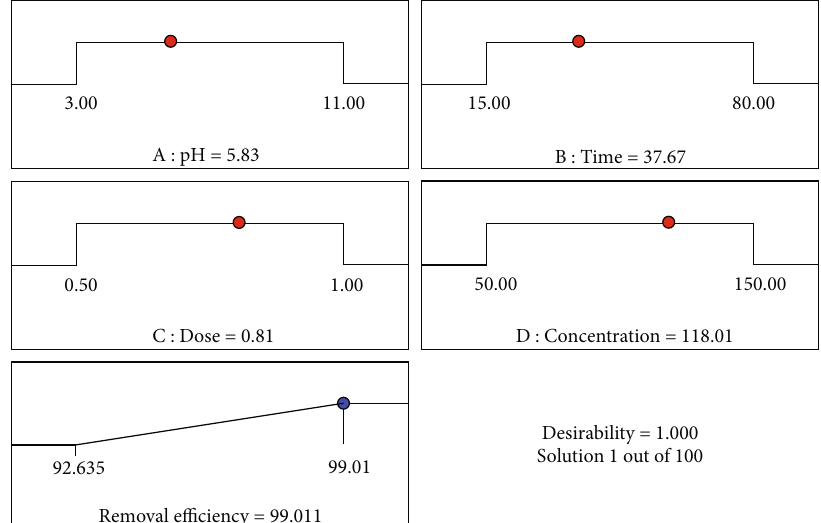
Figure 8: Desirability e ff ect for the CEX-Fe